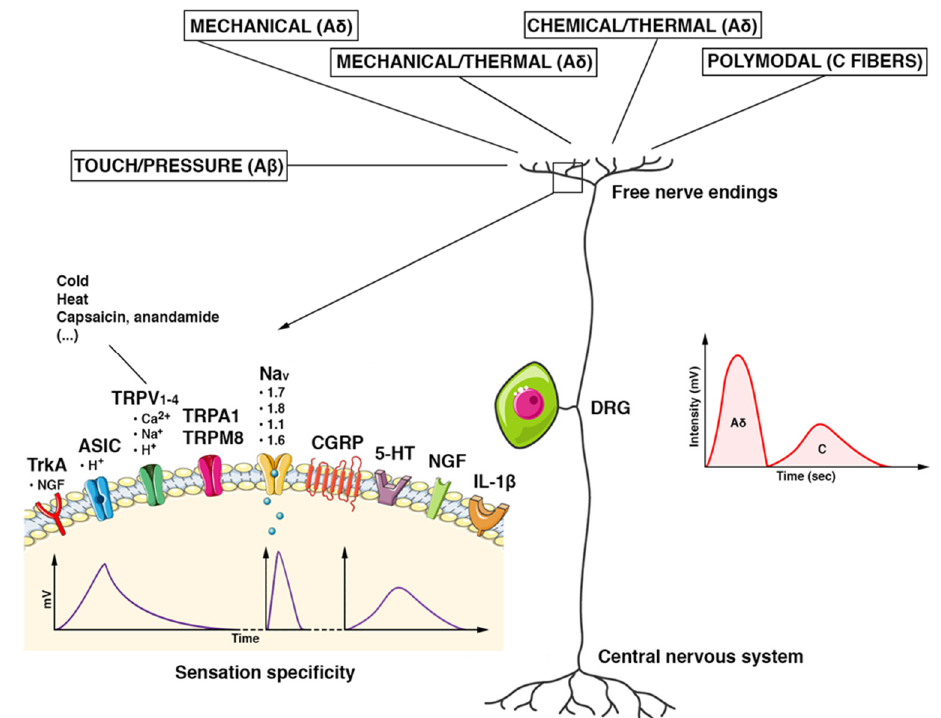
Figure 2. Schematic features of the DRG nociceptor. The pseudounipolar neuron has its cell body located in the dorsal root ganglion (DRG). Once the stimuli reach the terminal receptor, an ionic current is generated. It provokes a gradual potential that modulates the discharge of action potentials in the afferent nerve fibers directed to the CNS. Each receptor generates an ionic current with its characteristic voltage response (intensity (mV) and duration (Time)) and determines the specificity of the sensation. Stimuli are carried by multiple types of fibers. Tactile/pressure stimuli are conducted by A β fibers, mechanical/thermal/chemical stimuli by A δ fibers, and polymodal stimuli by C fibers. A δ fibers are myelinated, fast-conducting fibers. They conduct the first part of the pain stimulus, which is the most defined, acute, and superficial one (a spike of intensity in a shorter time). The non-myelinated C fibers are slow-conducting and convey the second part of a pain stimulus in a more lasting, profound, and less defined way (reduced in intensity and longer in the time). Abbreviations. TrkA: tropomyosin kinase A receptor; ASIC: acid-sensitive ion channel; TRPV1–4: transient receptor potential cation channel subfamily V; TRPA1: potential cation channel of the transient receptor, subfamily A, member 1; TRPM8: member of the M (melastatin) subfamily of the potential cation channel of transient receptor 8; Nav (1.1–1.8): voltage-gated sodium channels; CGRP: peptide related to the calcitonin gene; 5-HT: 5-hydroxytryptamine; NGF: nerve growth factor; IL-1 β : Interleukin 1 beta.